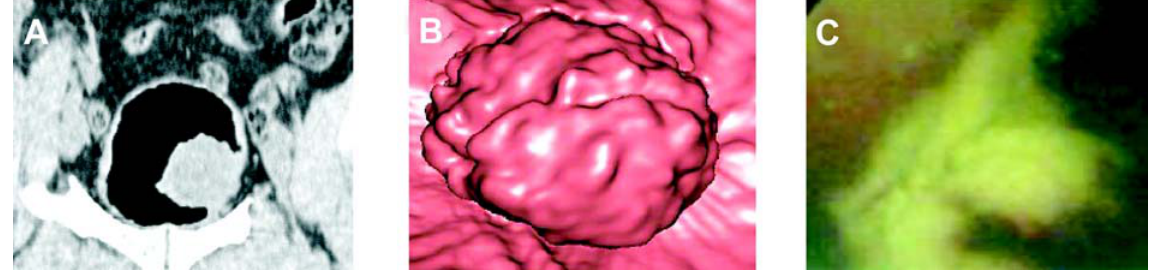
Figure 1 – 50-year-old man with transitional cell carcinoma obtained in area toward left wall shows polypoid lesion. A) Coronal multiplanar reconstruction section. B) Virtual CT cystoscopy appearance. C) Conventional cystoscopy. Vegetative surface of the tumor was clearly identified in virtual CT cystoscopy. Surrounding mucosal surface appears normal both of the conventional and virtual CT